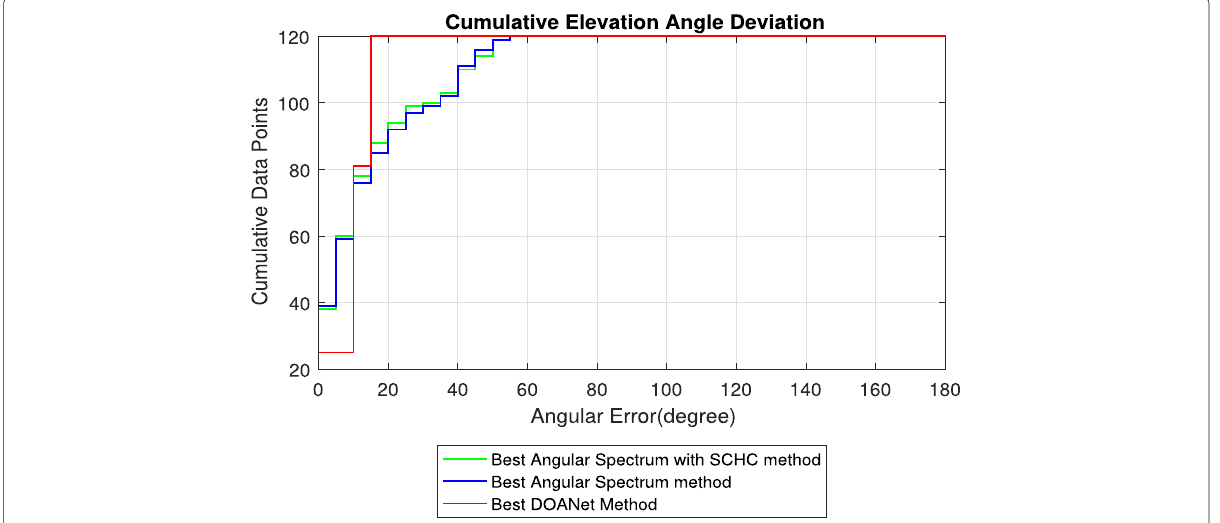
Fig. 9 AUCs for cumulative static elevation angle